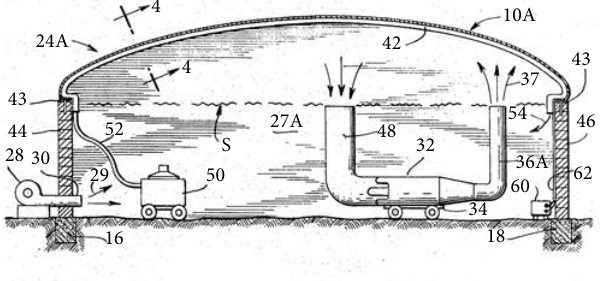
Figure 9: Method developed by MacCracken for building rein- forced plastic shells by inflating the formwork and hardening the shell by heating